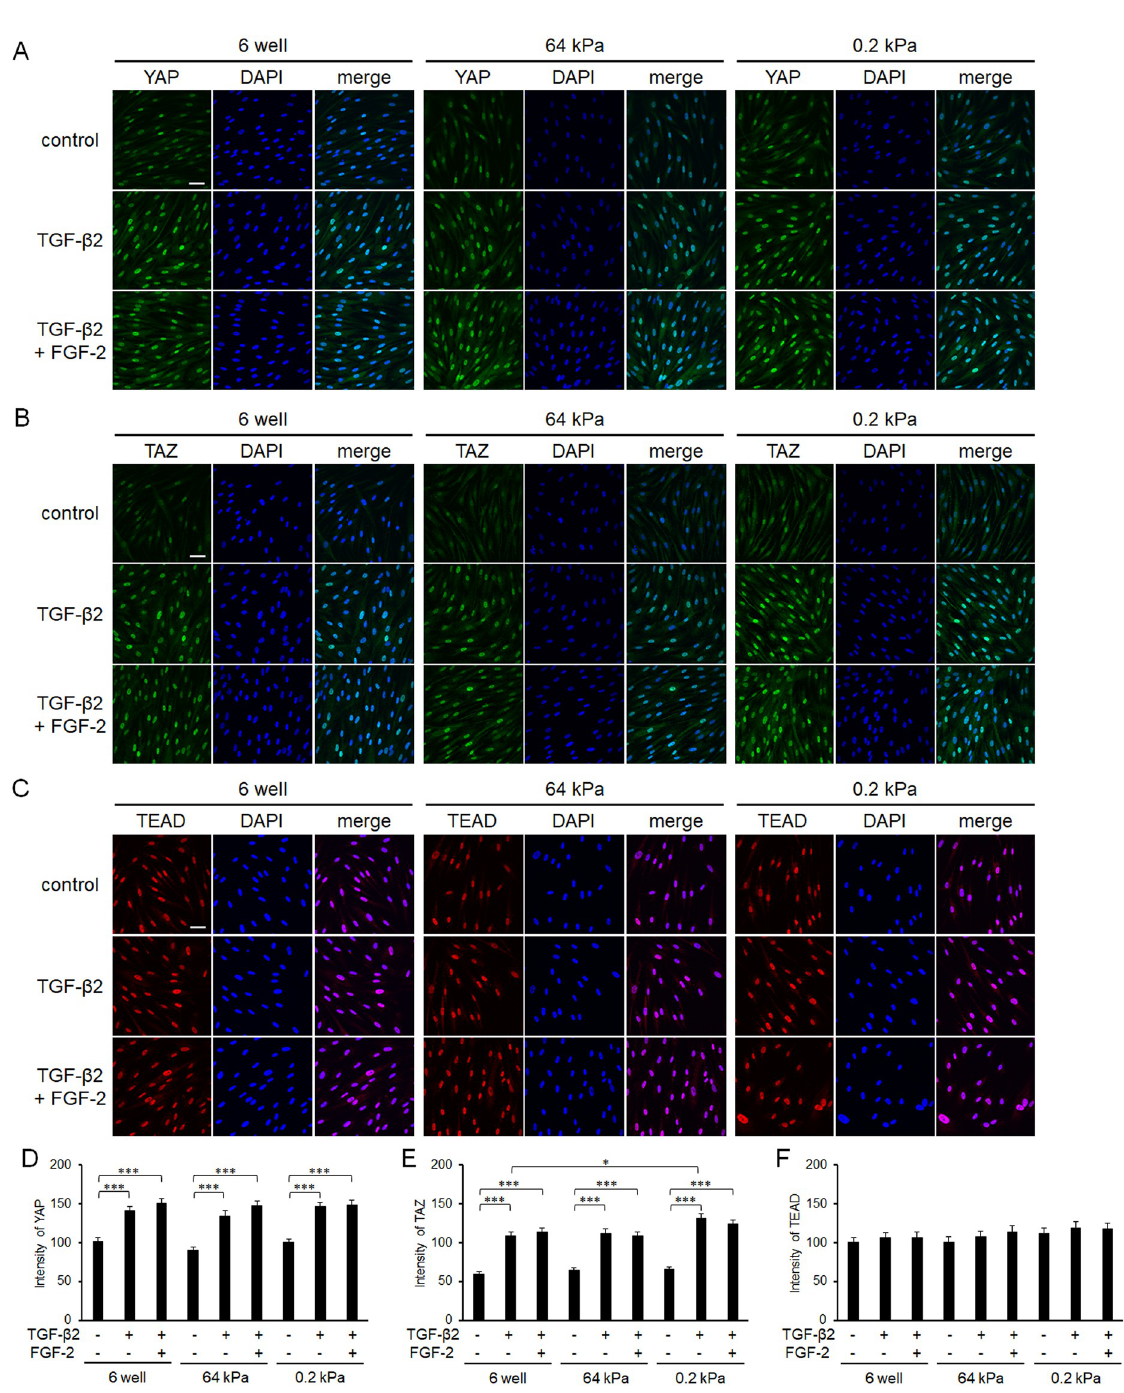
Fig 7. Effects of FGF-2 and/or a soft substratum on the subcellular locations of YAP, TAZ, and TEAD. Conjunctival fibroblasts were cultured on normal plastic wells or soft substratum wells (64 or 0.2 kPa), treated with FGF-2 (10 ng/mL) and/or TGF- β 2 (2.5 ng/mL) for 24 h, and then subjected to immunocytochemical analysis (A-C). The nuclear localizations of the molecules were quantified based on the co- staining with DAPI (D-F). Although the nuclear levels of YAP and TAZ increased by TGF- β 2 treatment, those of YAP, TAZ, and TEAD were not significantly affected by FGF-2 or substratum stiffness (n = 3). Scale bar: 50 μ